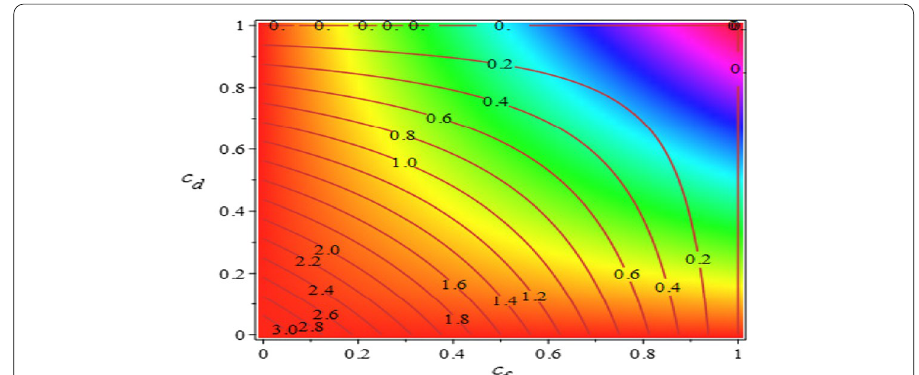
Fig. 9 Contour plot of R 0 for the model (1), as a function of social distancing and face masks